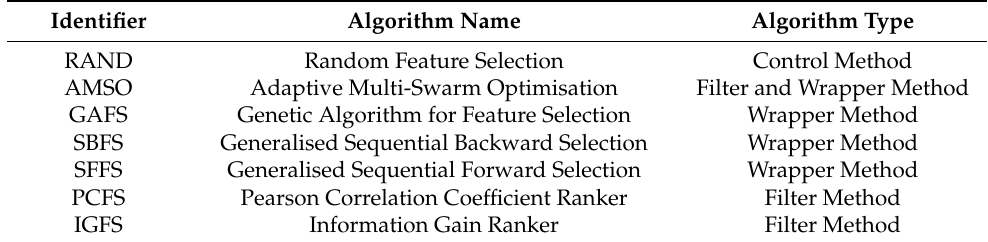
Table 7. Feature selection